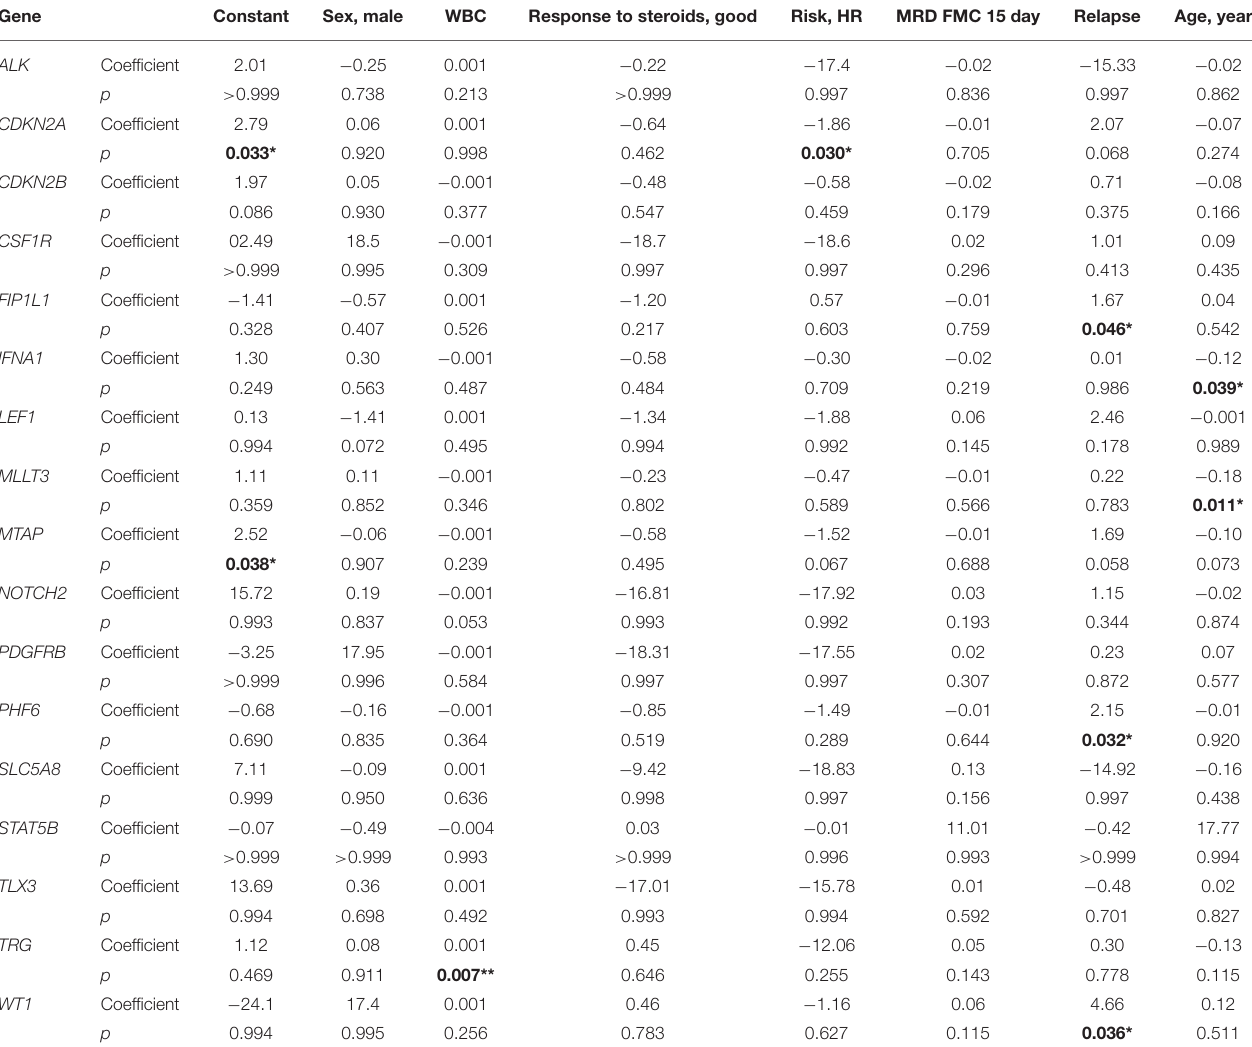
TABLE 3 | Variables predictive of CNVs in particular genes in multivariate logistic regression coefficient– β coefficient in logistic regression model with CNVs as the outcome variable. Gene Constant Sex, male WBC Response to steroids, good Risk, HR MRD FMC 15 day Relapse Age,